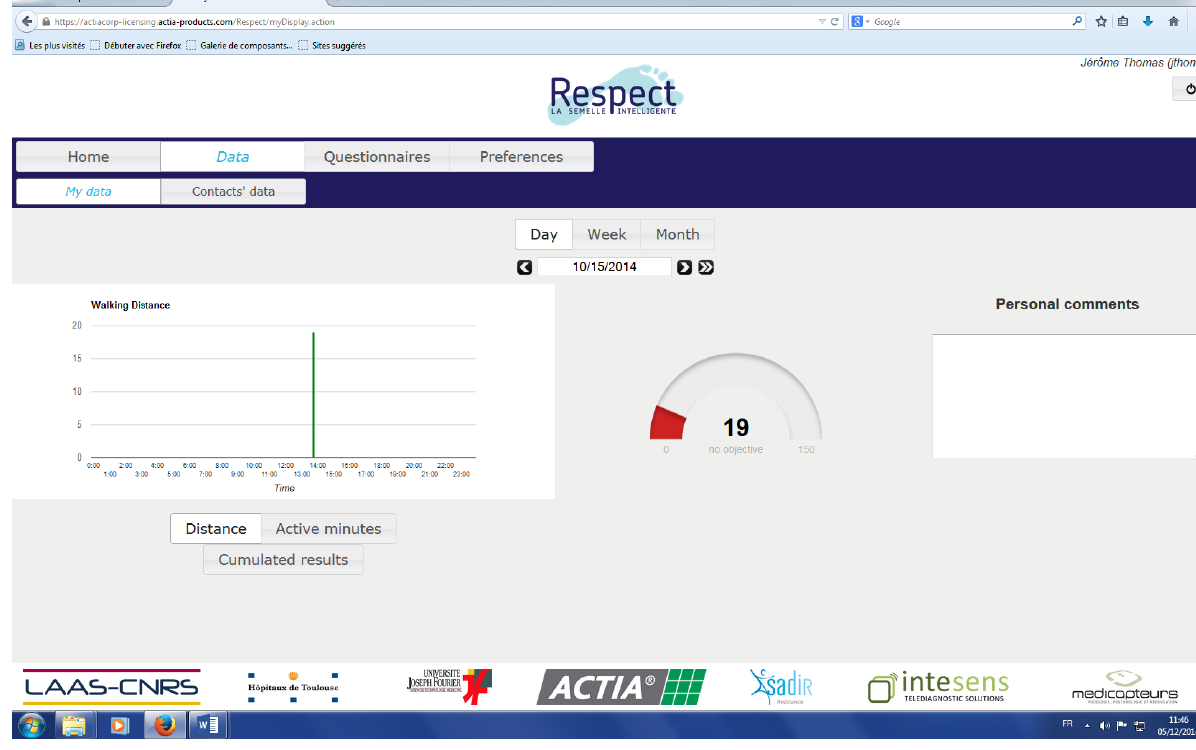
Figure 6. Physician